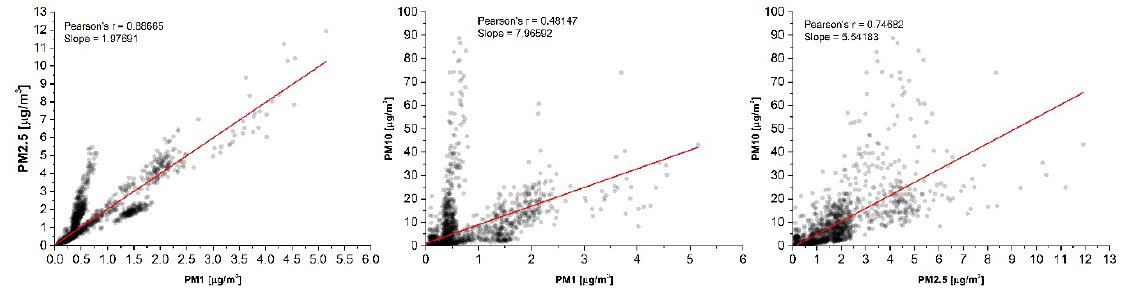
13 of 18 Figure 8. Correlation among the PM readings of the PMS5003 monitor. The data represent all measurements for one representative day. Similar results were obtained for the remaining single days,